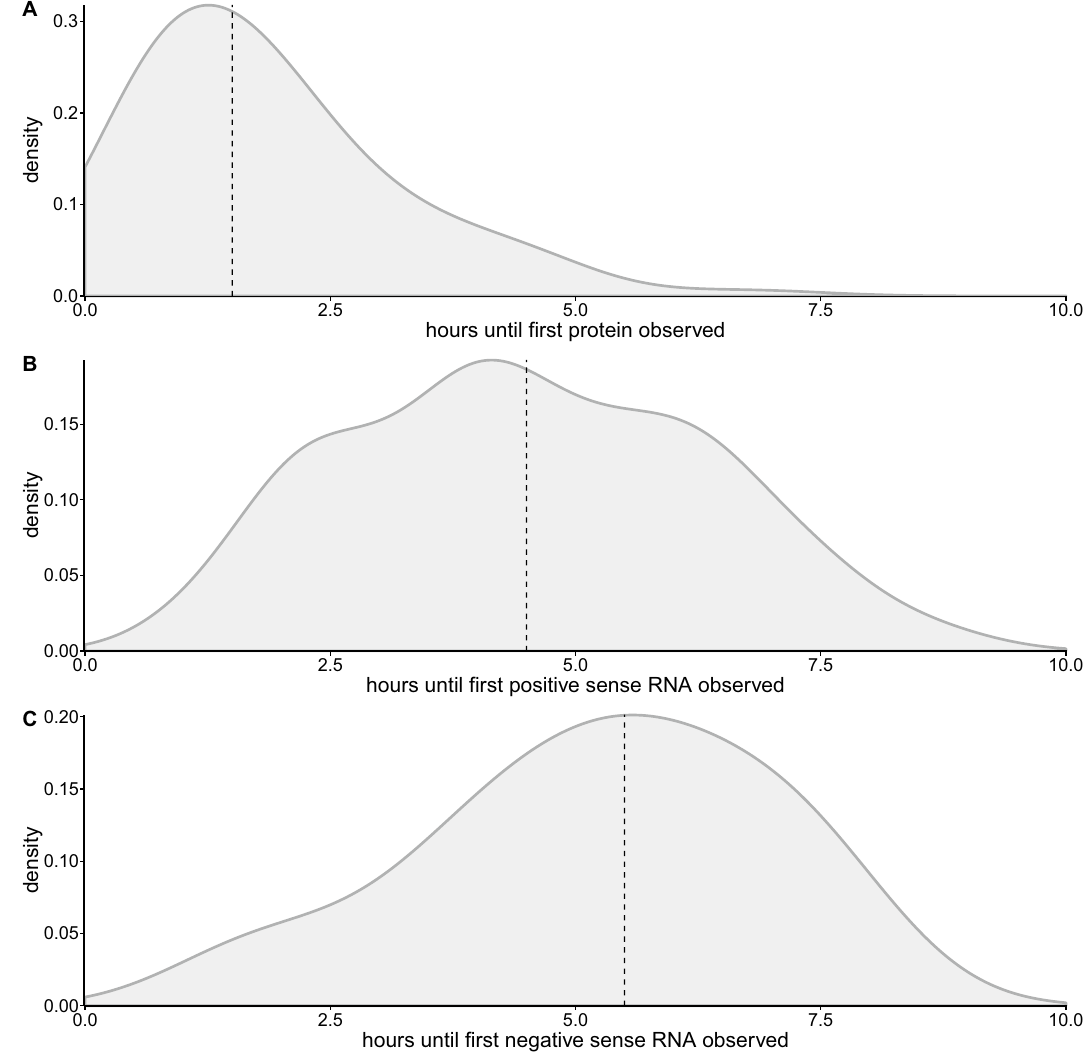
Figure 3. Time until first occurrence of events as estimated from our model of PV infection when the model is fit to the experimental data shown in Fig. 1C–F. ( A ) Hours until protein is first produced. ( B ) Hours until the first production of positive sense RNA. ( C ) Hours until the first production of negative sense